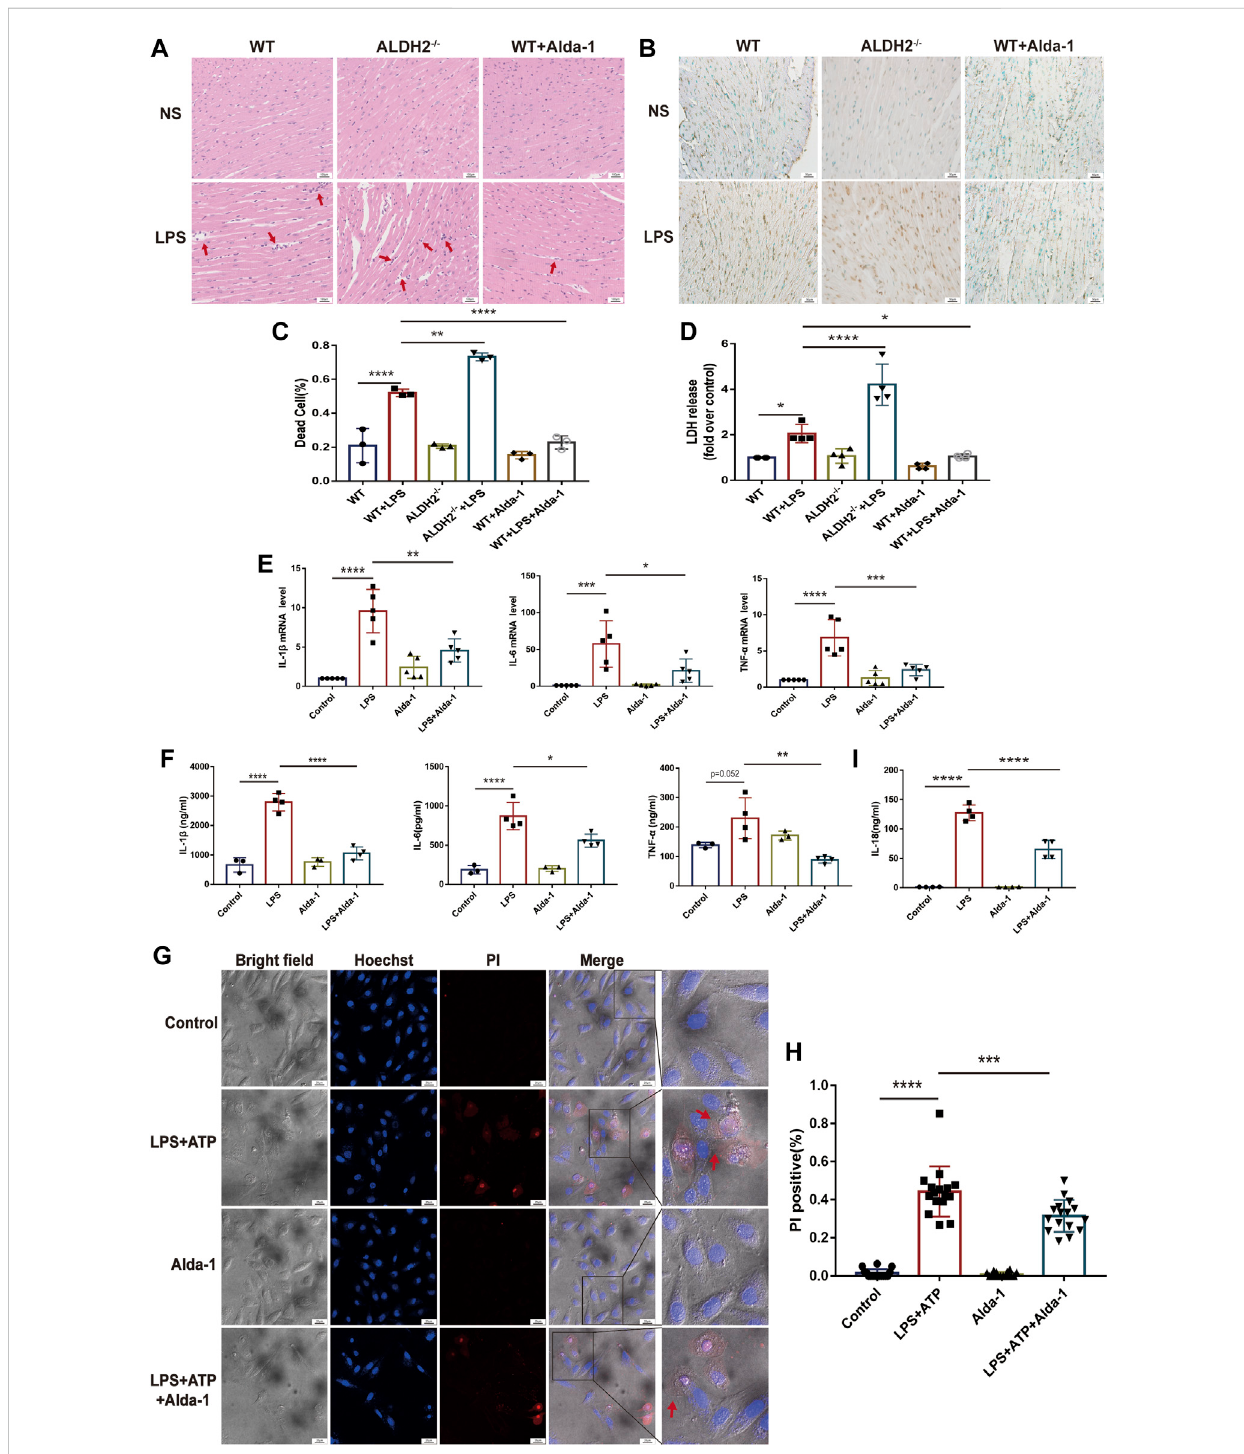
FIGURE 2 ALDH2attenuatesLPS-inducedmyocardialpyroptosisandin fl ammationinsepticshock. (A) RepresentativeHEstainingimagesofcardiactissue,red arrows indicate in fl ammatory in fi ltration, scale bar: 100 μ m. (B,C) Representative TUNEL staining images of cardiac tissue and the quantitative analysis, scalebar:50 μ m. (D) ThequantitativeanalysisofLDHreleaselevels, n =4pergroup. (E,F) ThequantitativeanalysisofRT-qPCRandELISAresultsincluding IL-1 β , IL-6, and TNF- α . N = 3 – 5 per group. (G,H) Representative morphological changes of pyroptosis in bright fi eld and PI staining and the quantitative analysis of the PI positive H9C2 cells, red arrows indicate bubbling of pyroptotic cells, scale bar: 25 μ m. (I) The quantitative analysis of